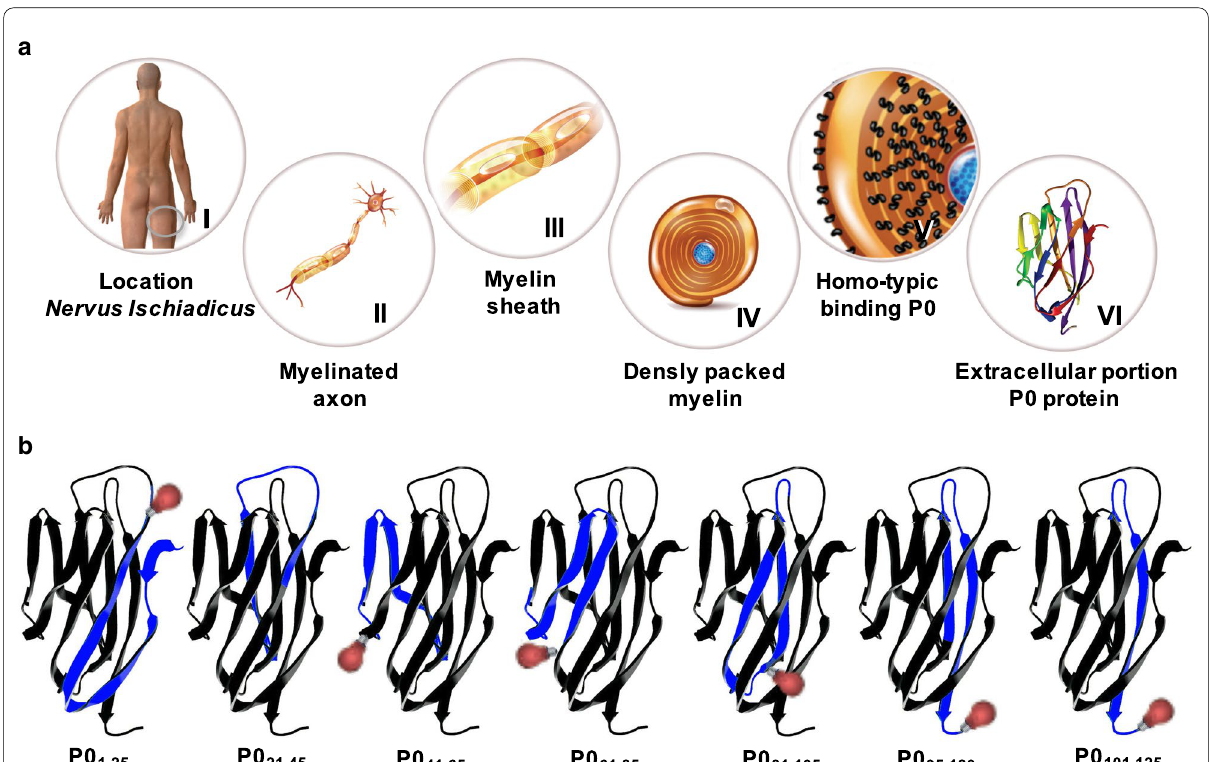
Fig. 1 Myelin protein zero as a target for nerve imaging. A schematic overview of the localization of myelin protein zero (P0) in the peripheral nervous system with (I) the location of the nervus ischiadicus (encircled in grey), (II) myelinated axon within this nerve, (III) the myelin sheath encapsulating the axon, (IV) densely packed myelin within the myelin sheath, (V) homotypic binding of P0 within the myelin sheath (location P0 on outer membrane and between layers annotated in black) and (VI) the crystal structure of the extracellular portion of P0 (P0 ex ). B Peptides P0 1–25